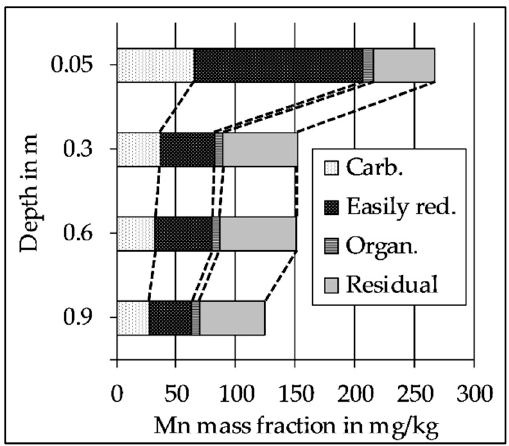
Figure 7. The median values ( n = 3) of percentage Mn mass fractions along the columns.